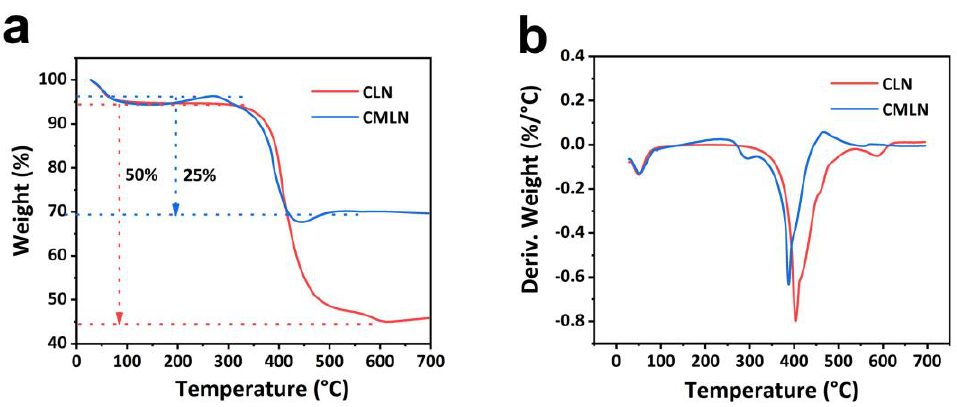
Figure 1. ( a ) TGA curves of CLN and CMLN; ( b ) DTG of CLN and CMLN.